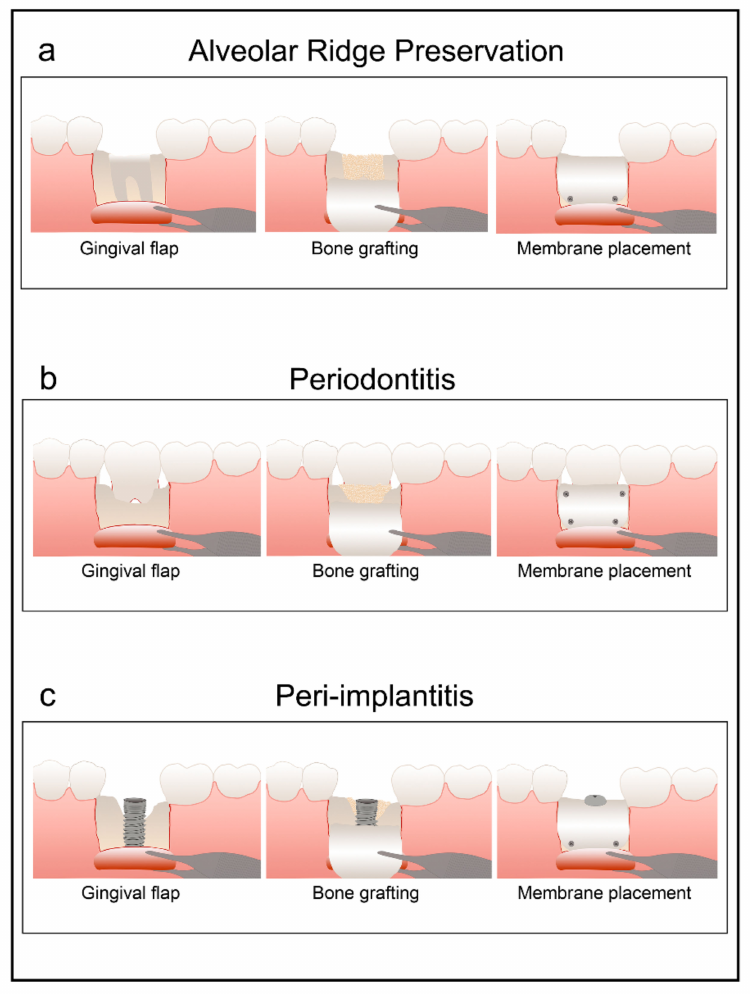
Figure 1. Illustration representing the surgical protocol for alveolar ridge preservation with mem- branes after tooth extraction ( a ). Use of membrane in regenerative procedures for periodontal defects ( b ). Membranes for peri-implantitis regeneration ( c ). In all cases, membranes are stabilized with mini-screws and pins to the surrounding